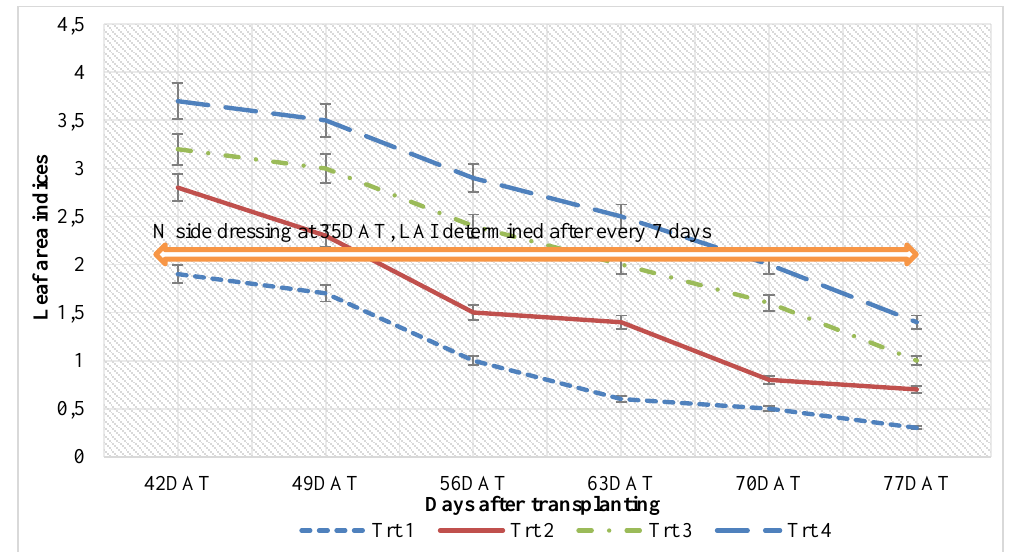
Figure 5b . Leaf area index responses over growing seasons after N fertilizer application